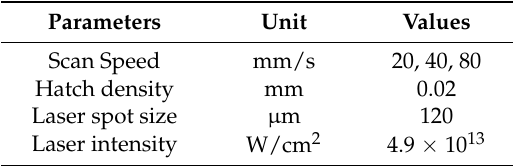
Table 2. Femtosecond (fs) laser processing